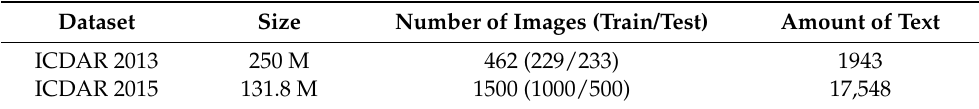
Table 2. Experimental datasets.